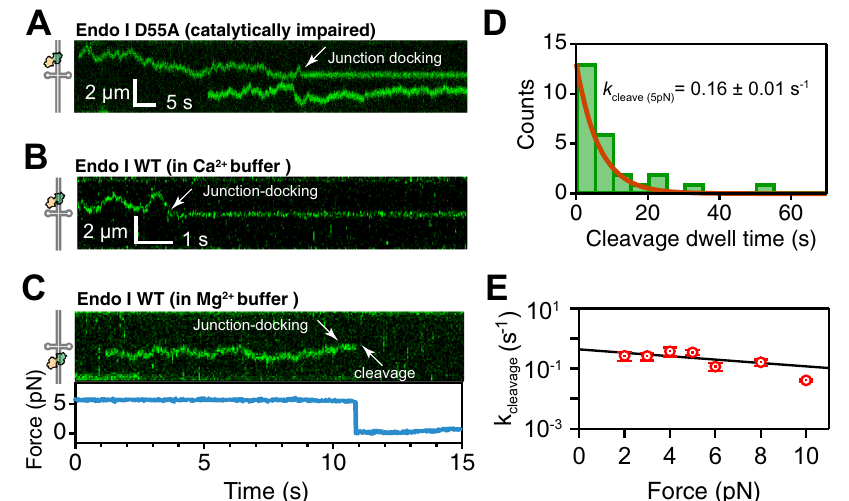
Fig. 4 | Observation of catalytically-active endonuclease I resolving a four-way junction. A A kymograph showing the catalytically impaired endonuclease I D55A mutant that diffuses on dsDNA until it encounters the centrally-located four-way junction. Oncedocked onits target, the proteinremainsbound forlongperiodsof time. B A kymograph showing the wild type endonuclease I in conditions that supress its enzymatic activity. The protein diffuses on dsDNA, remains docked on the four-way junction without cleaving the DNA. C A kymograph showing the wild type endonuclease I in a buffer with Mg 2+ cations. The corresponding force